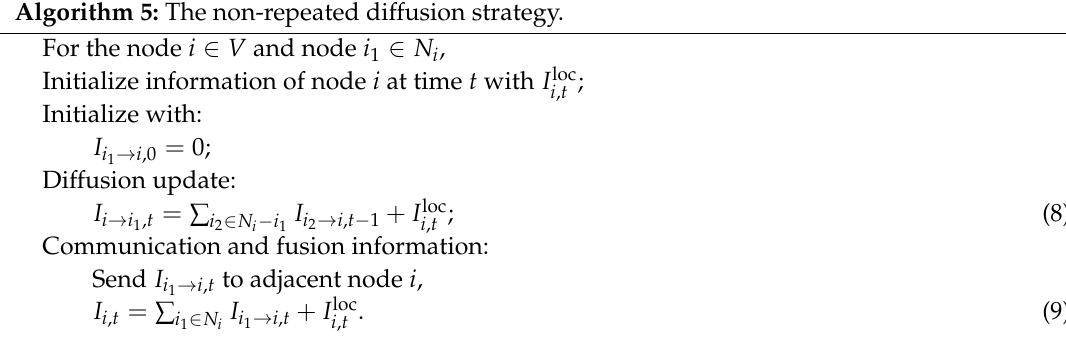
Algorithm 5: The non-repeated diffusion